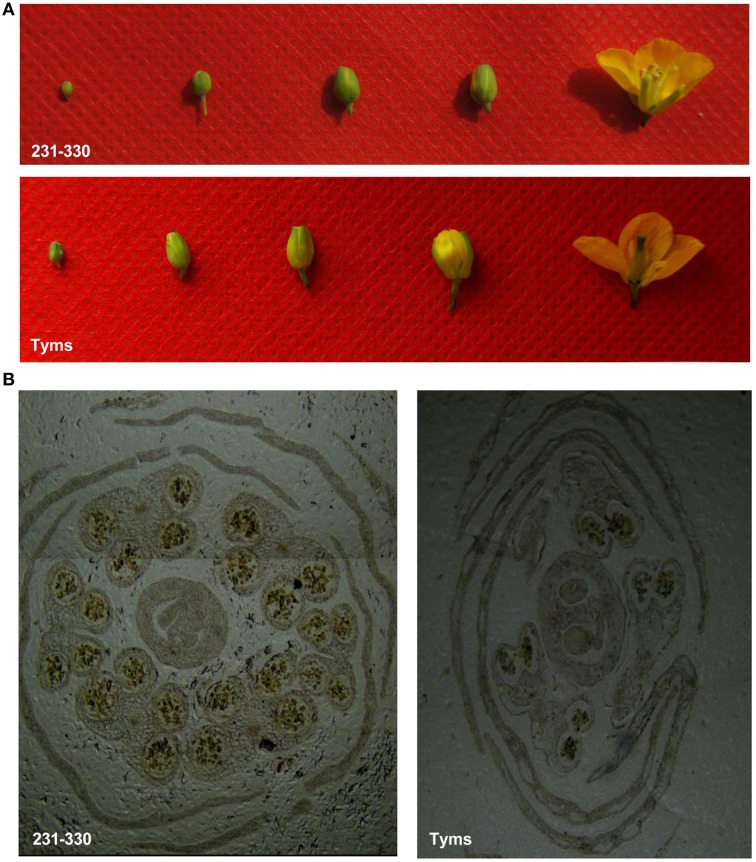
The buds and flowers of the Ogura-CMS (Tyms) and maintainer (231-330) lines. (A) the buds of four developmental stages and the flower that were sampled for this study. (B) microscopy of the buds showing the well-developed pollen sacs in 231–330 and incomplete development in Tyms.